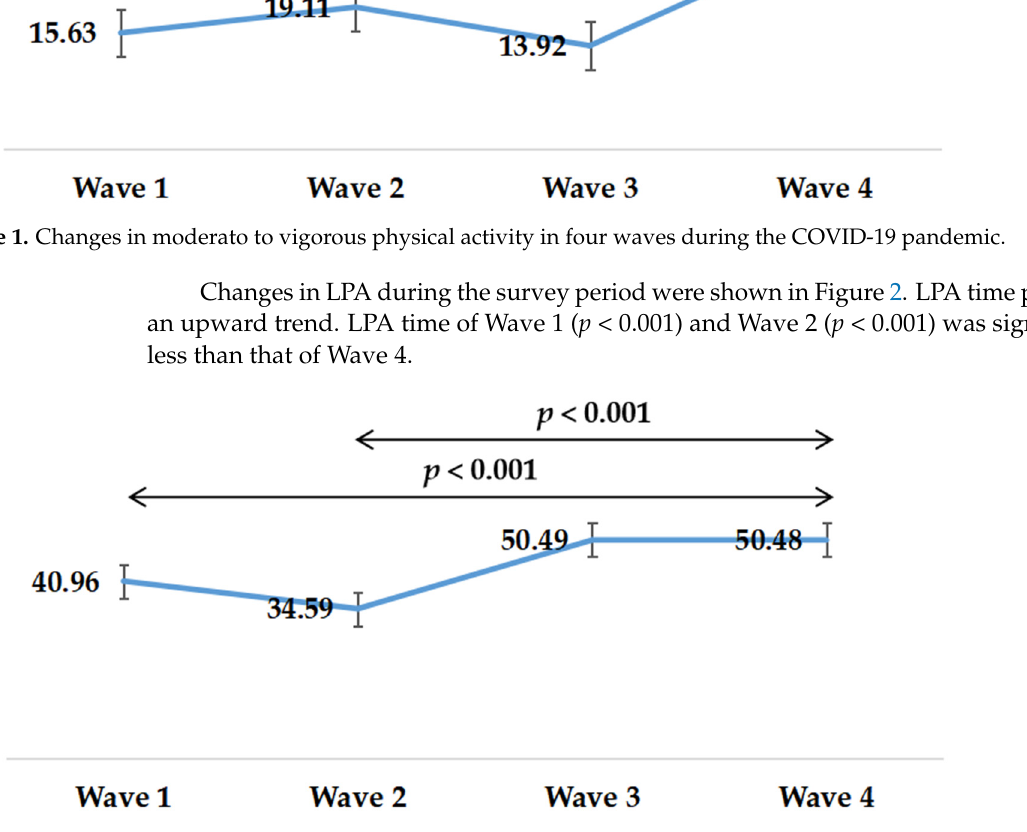
Figure 3. Changes in sedentary behavior in four waves during the COVID ‐ 19 pandemic. Tables 3–5 presents the results from GEE on the predictors of changes in MVPA, LPA, and SB of the study participants. In our results, residence, age, perceived family affluence, and BMI were not predictors of changes in MVPA in study samples, while sex was the only predictor of changes in MVPA in study samples, indicating that female young adults were more likely to report less time spent in MVPA compared with their male counter ‐ parts (Table 3). As for LPA, there were no significant associations between selected factors and outcomes, suggesting that no predictors of LPA in our study (Table 4). Concerning SB, it was evident that sex and perceived family affluence were significant predictors of changes in SB in study samples (Table 5).